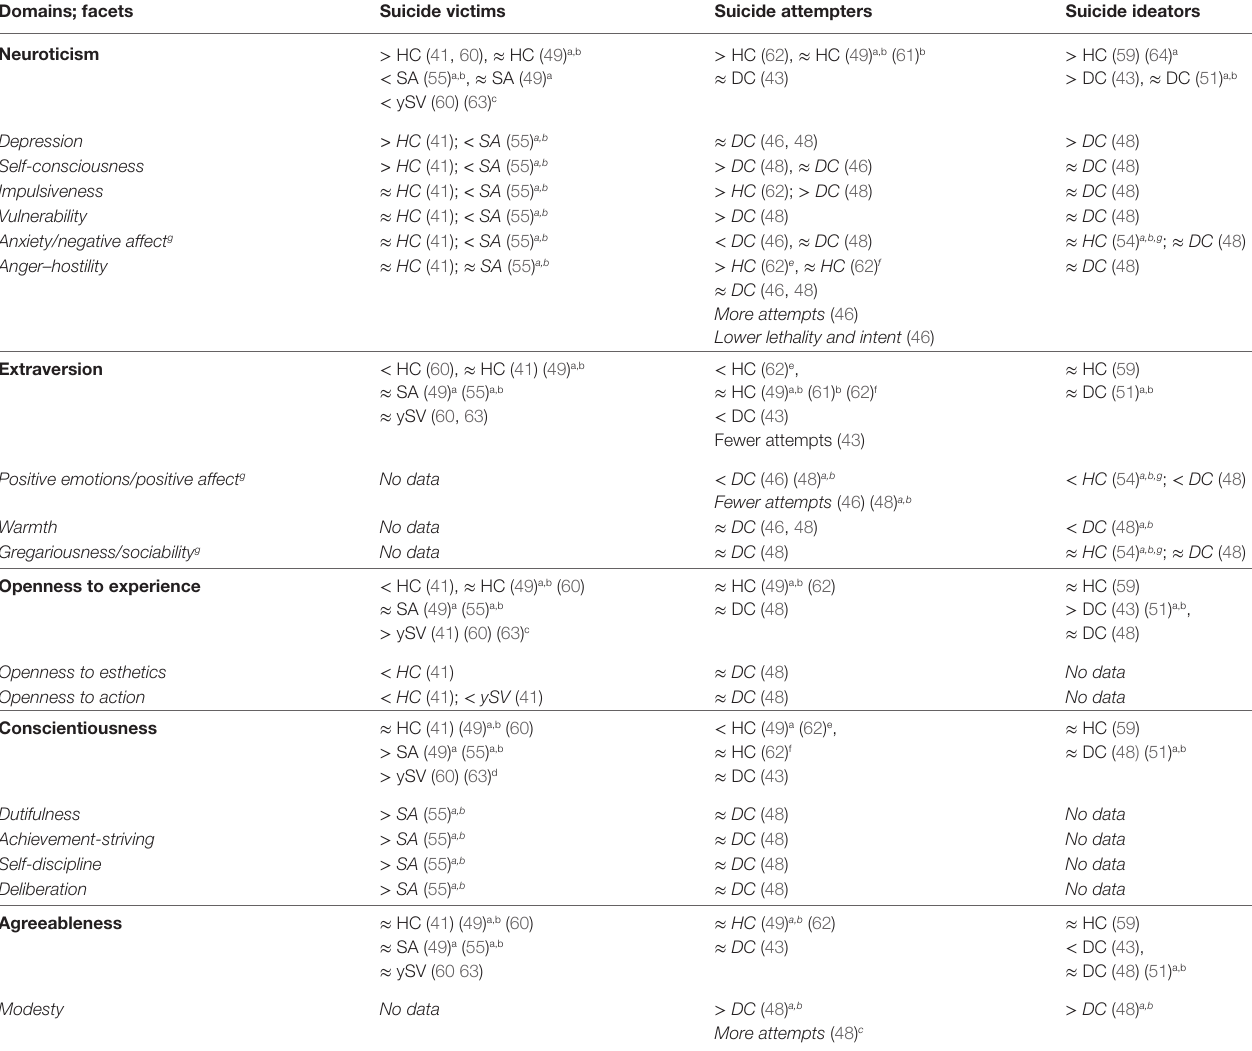
taBLe 5 | Summary of dimensional findings on death by suicide, attempted suicide, and suicidal